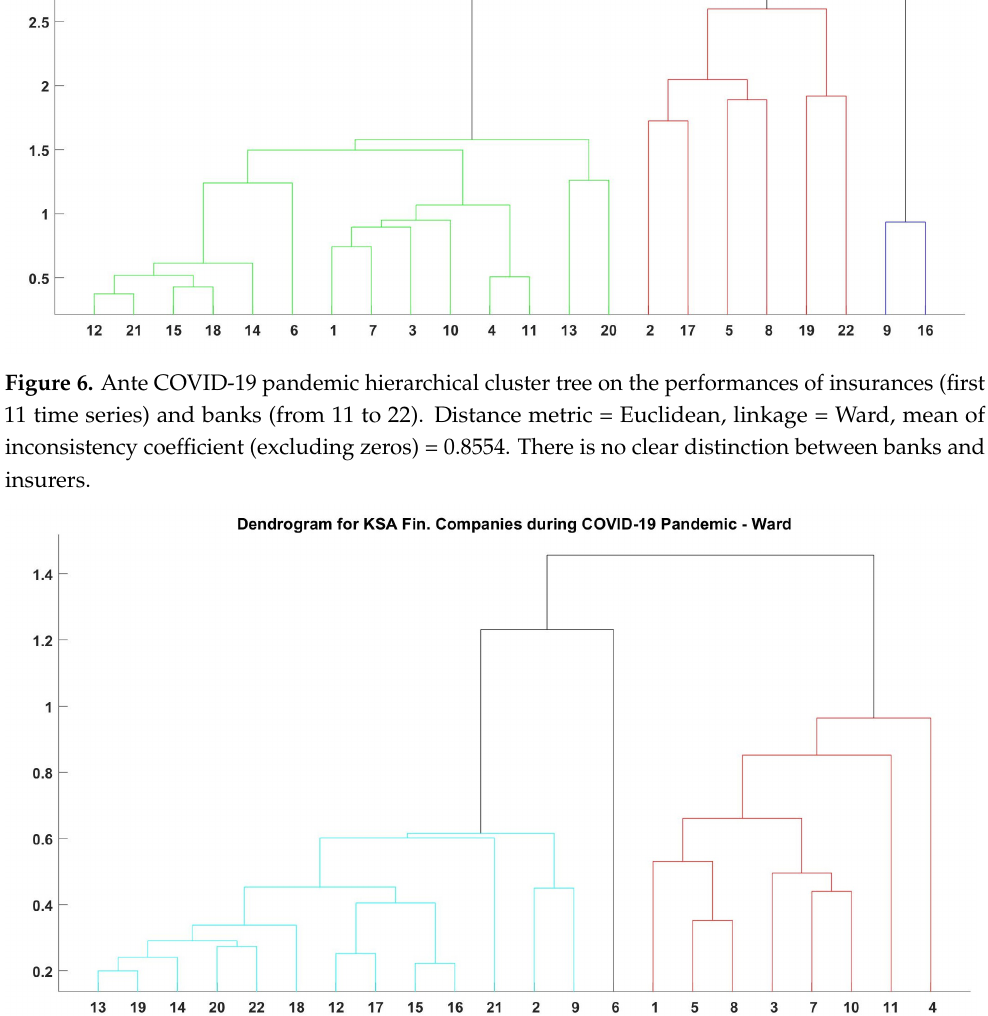
Figure 7. COVID-19 pandemic hierarchical cluster tree on the performances of insurances (first 11 time series) and banks (from 11 to 22). Distance metric = Euclidean, linkage = Ward. Mean of inconsistency coefficient (excluding zeros) = 0.8127. The pandemic has created a separation between banks and